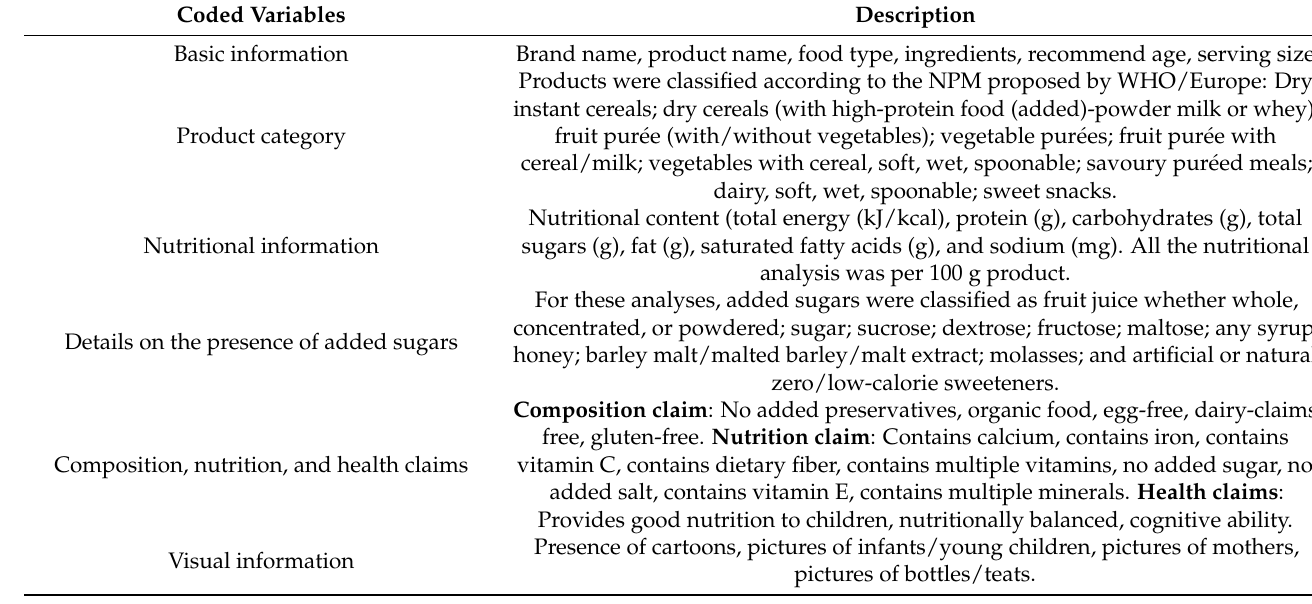
Table A1. Information on the coded variables that were subject to